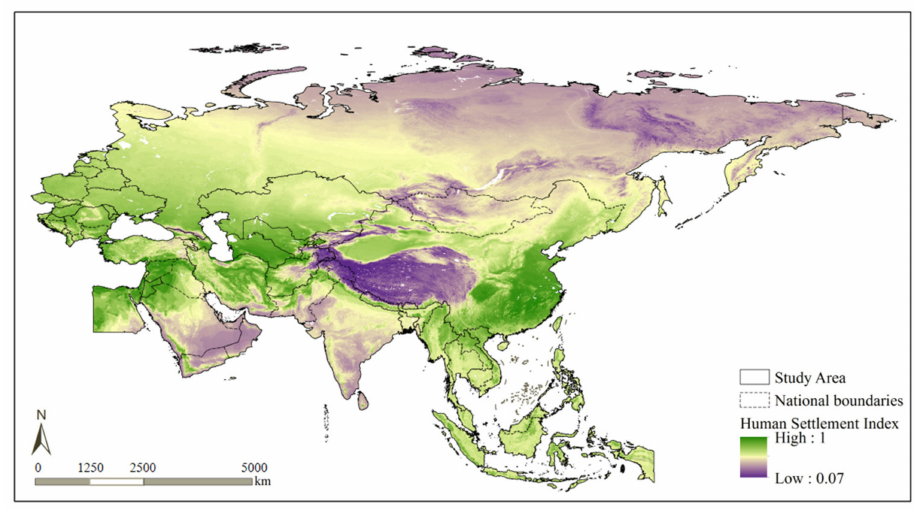
Figure 5. HSS model-based evaluation